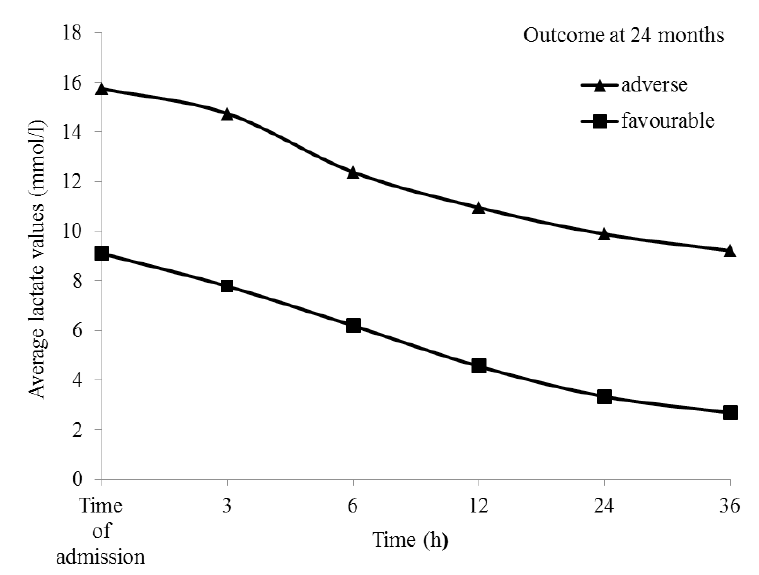
Fig. 1. Graphical representation of the change in lactate values in both groups of